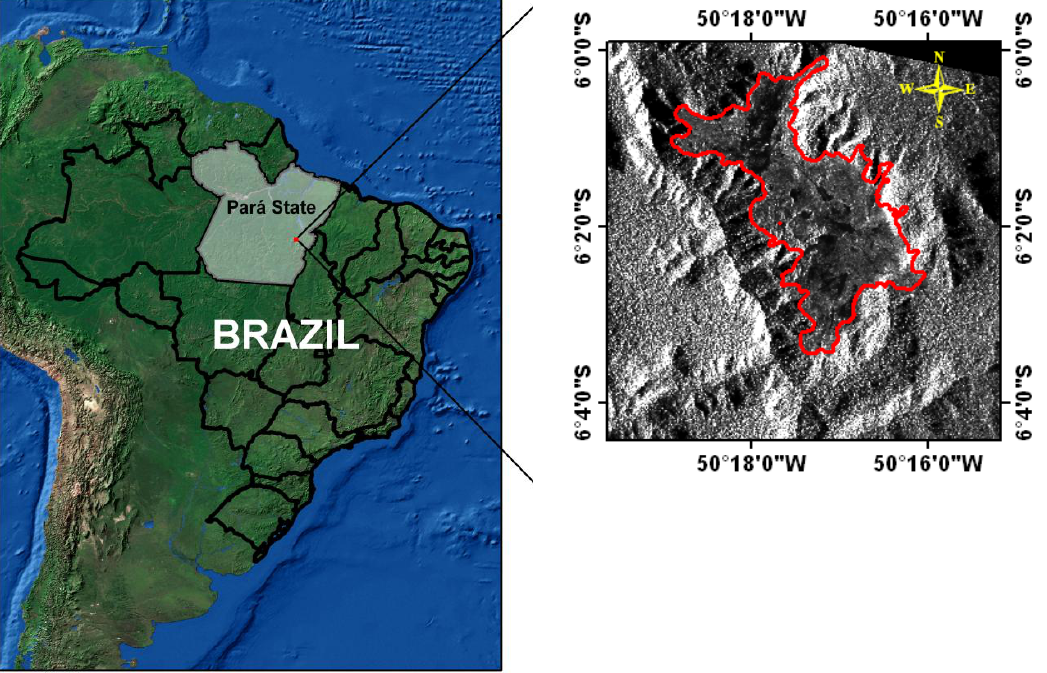
Figure 1. Location of the study area in the Brazilian state of